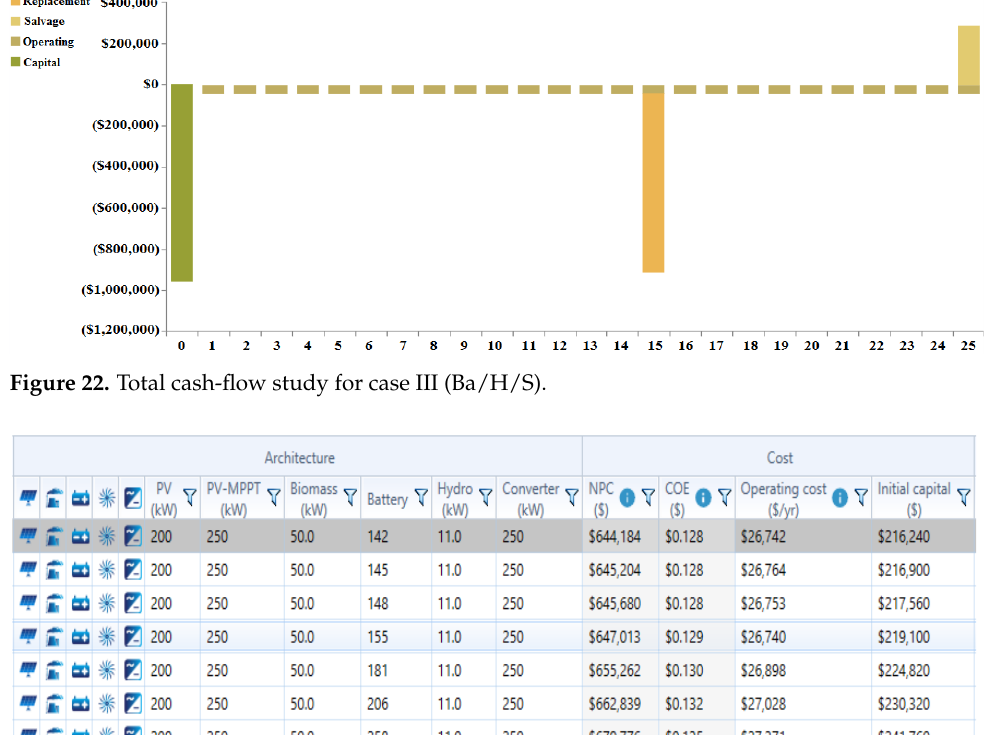
Figure 21. Total component cost breakdown for case III (Ba/H/S).